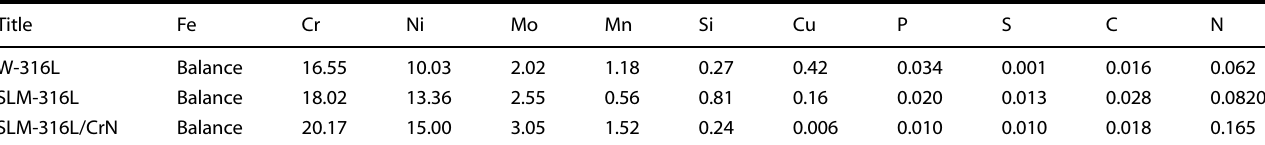
Table 2. Chemical compositions in wt.% of W-316L, SLM-316L and